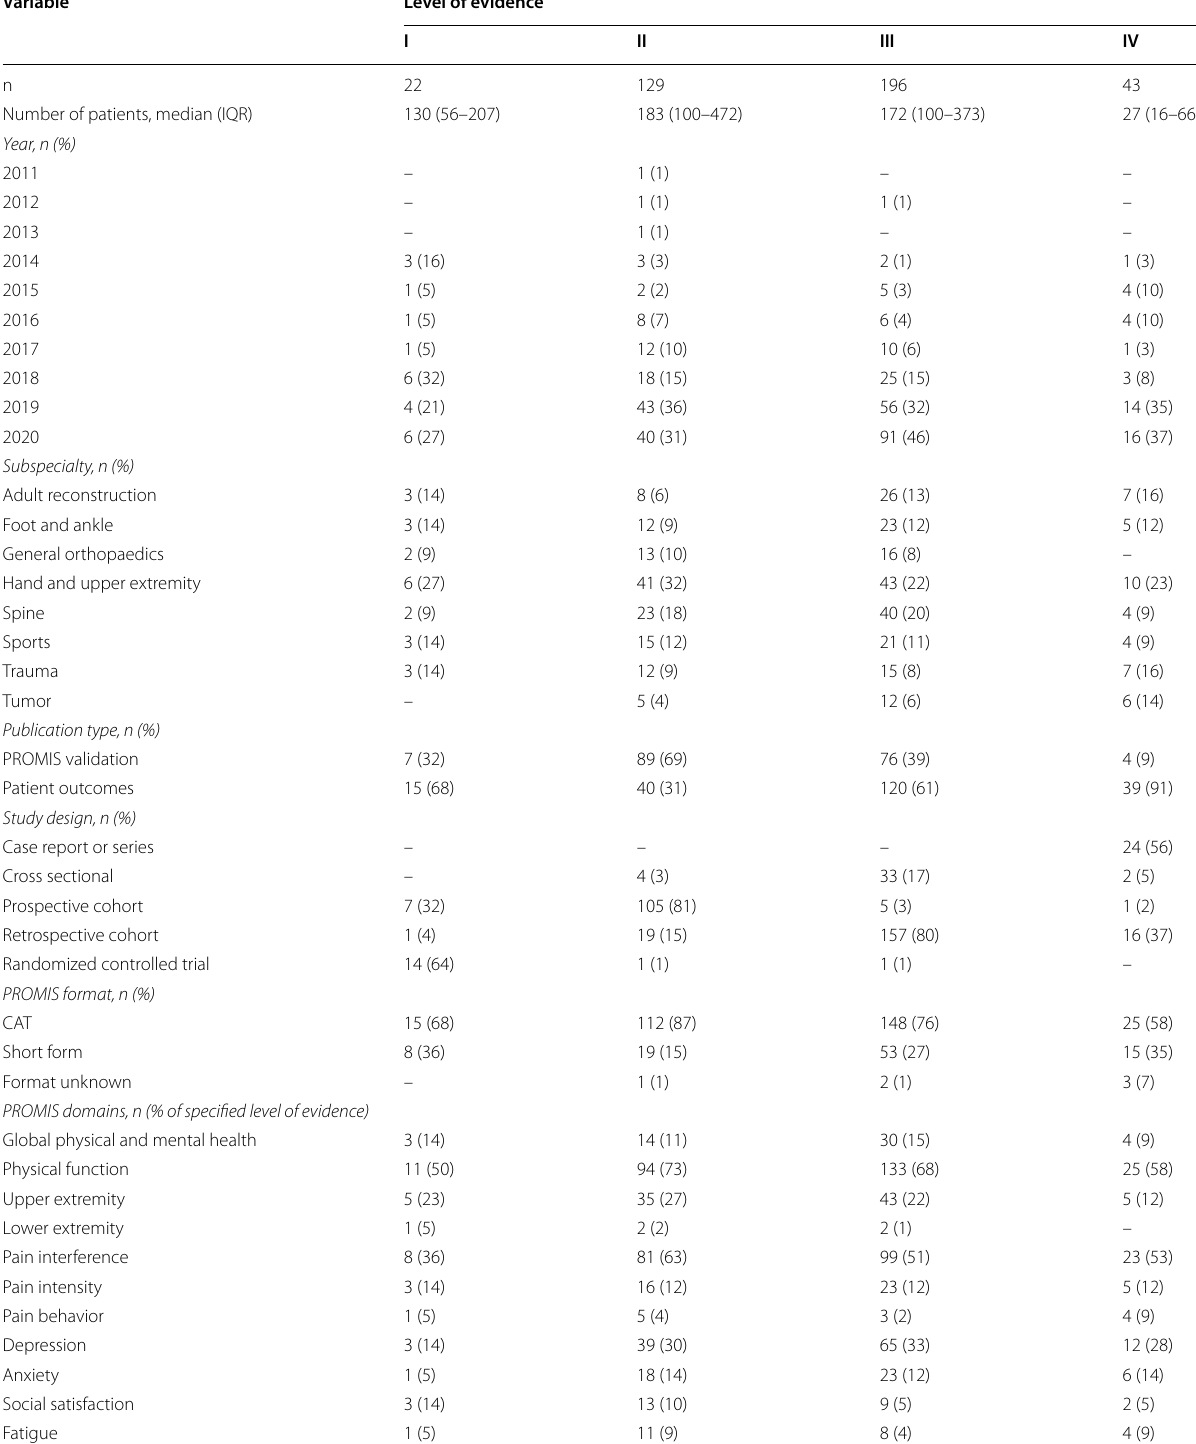
Table 3 Characteristics of all PROMIS publications by level of